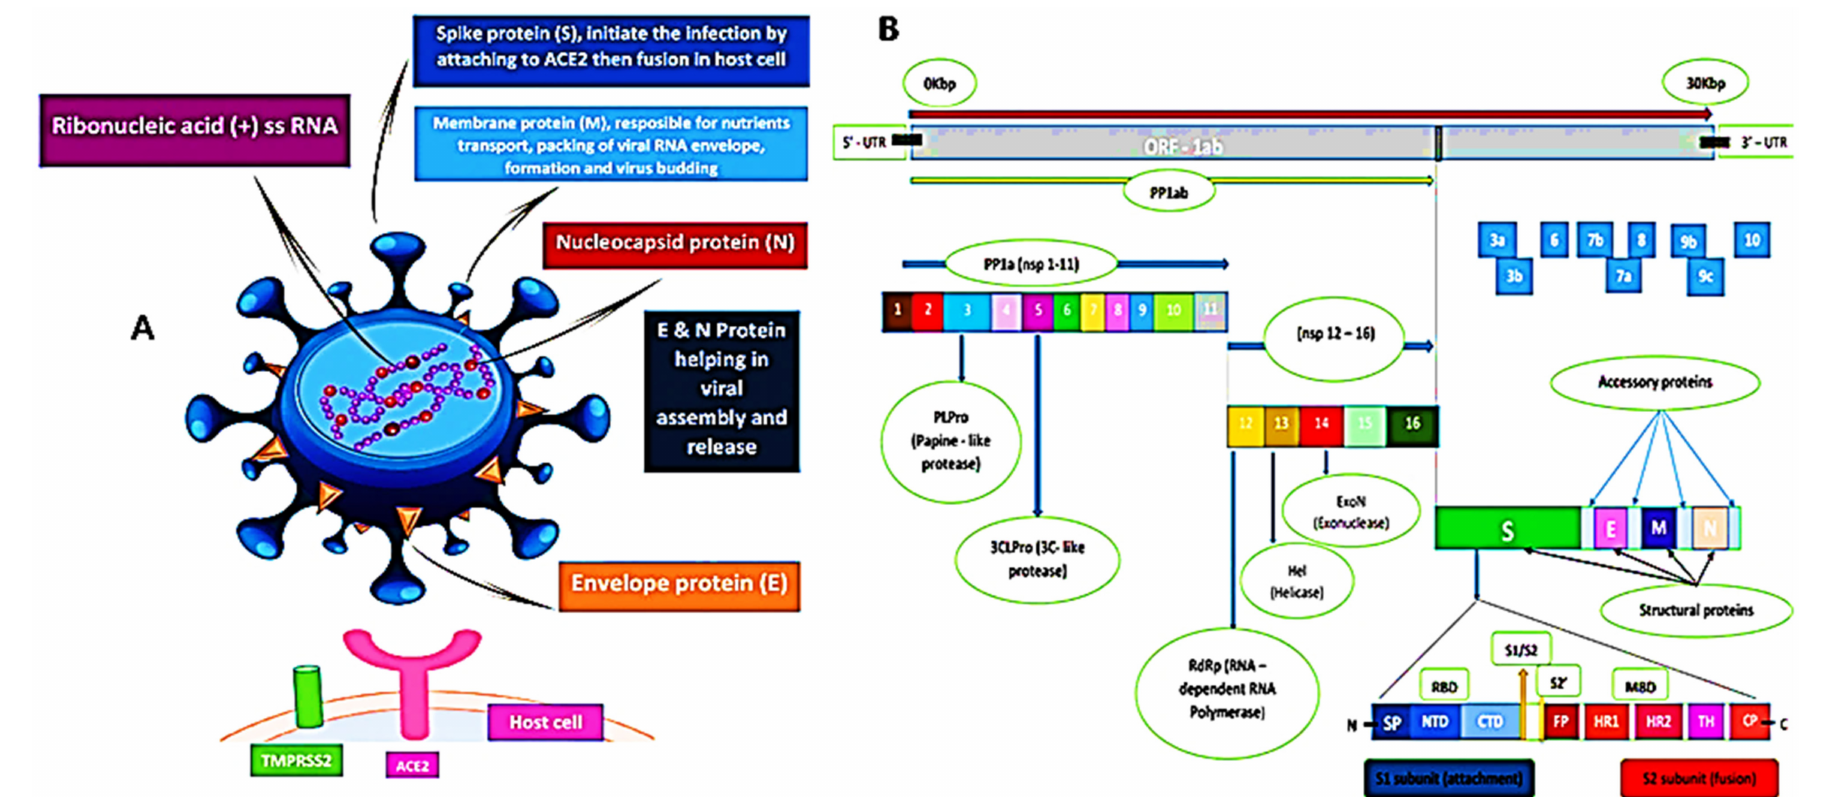
Figure 2. ( A ) 3D graphical presentation of the structure of SARS-CoV-2 and human host cell receptors. ( B ) SARS-CoV-2 genome encodes for 16 nonstructural proteins (nsp), four structural proteins S, M, E, and N, and accessory proteins. A cartoon figure of the SARS-CoV-2 S protein that contains the two subunits: S1 and S2, where S1 composed of: SP (signal peptide); NTD (N-terminal domain), and CTD (C-terminal domain), while S2 composed of FP (fusion peptide), HR1 (heptad repeat 1), HR2 (heptad repeat 2), TM (transmembrane), and CP (cytoplasmic). There are two cleavage sites at S protein denoted as yellow arrows (S1/S2) and (S2 (cid:48)